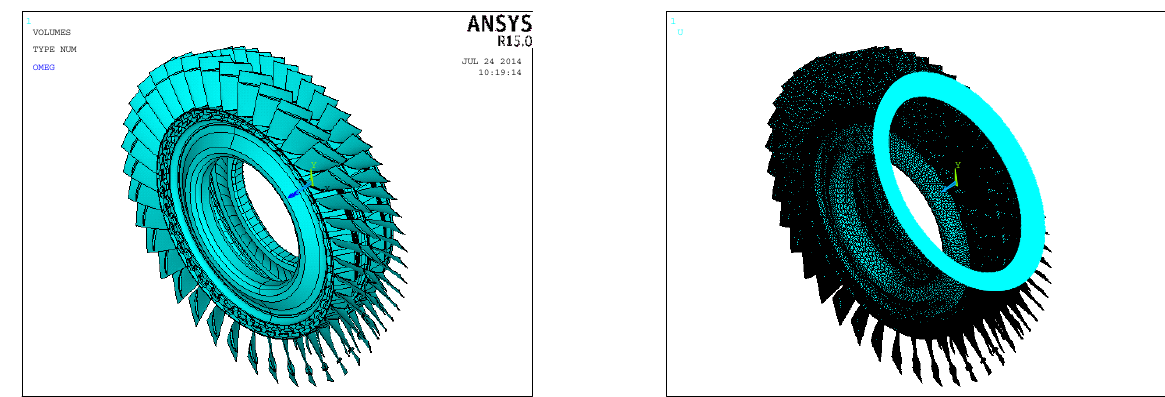
( b ) Finite element model of a two-stage bladed disk system Figure 14. Two-stage bladed disk system model. Figure 14. Two-stage bladed disk system model. Table 8. First 195 order natural frequencies of a two-stage bladed disk coupled system.